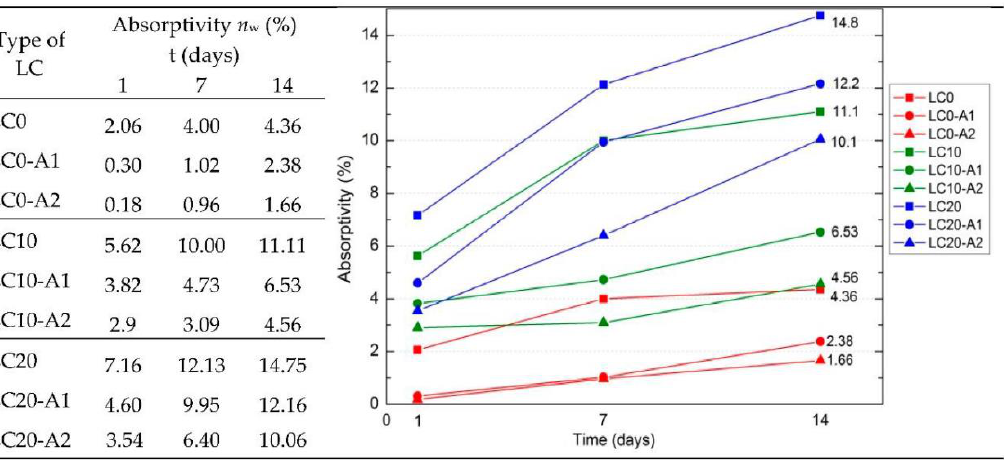
Figure 28. Water absorptivity of recycled PS-based concrete. Reprinted with permission from ref.